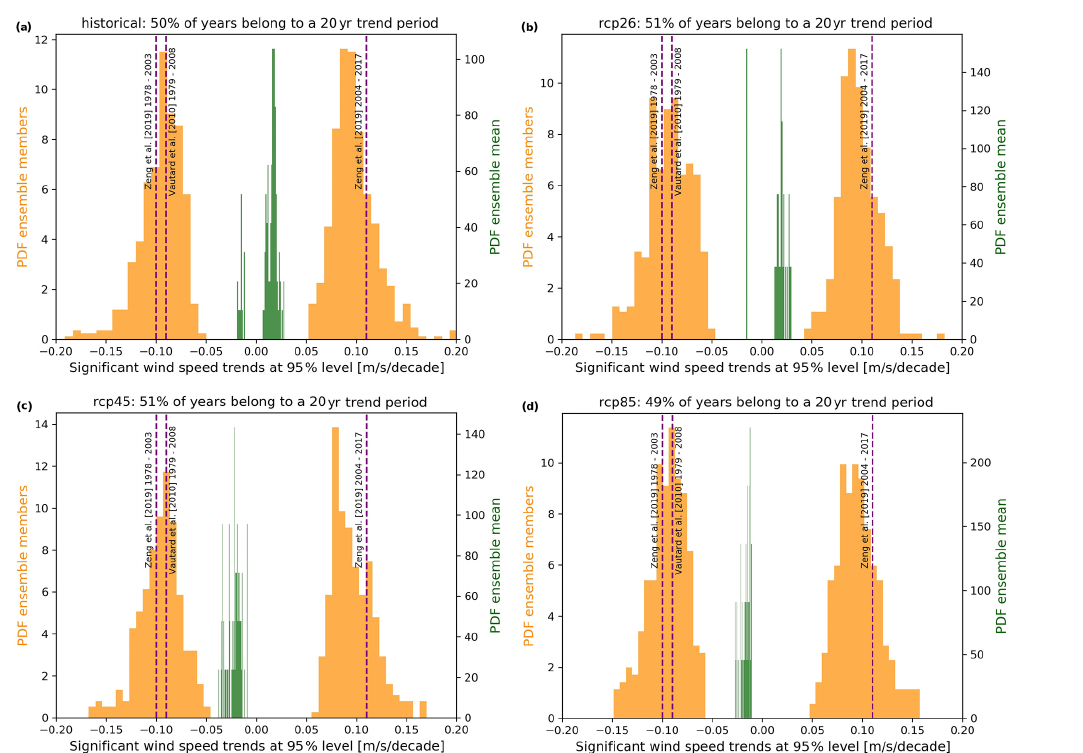
Figure 8. Twenty-year trends in European annual mean wind speed in MPI-GE under historic and future climate conditions. Trends are computed for each ensemble member after subtraction of ensemble mean (yellow – representing internal variability) and for the ensemble mean (green – representing forced changes). Different subplots show different experiments. Trends are only shown if they are different from zero at a 95% significance